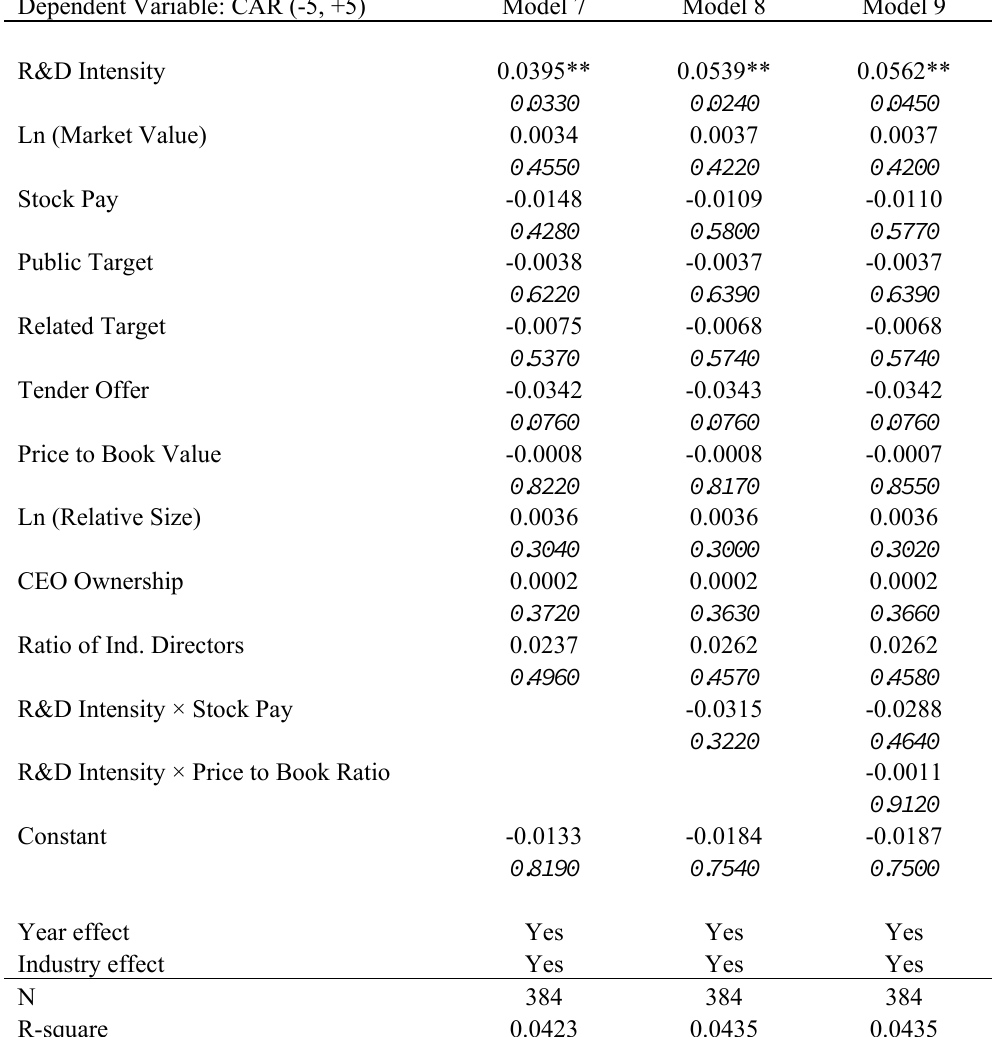
Table 7. Effects of Governance Variables on Acquirer’s Return (1997 –